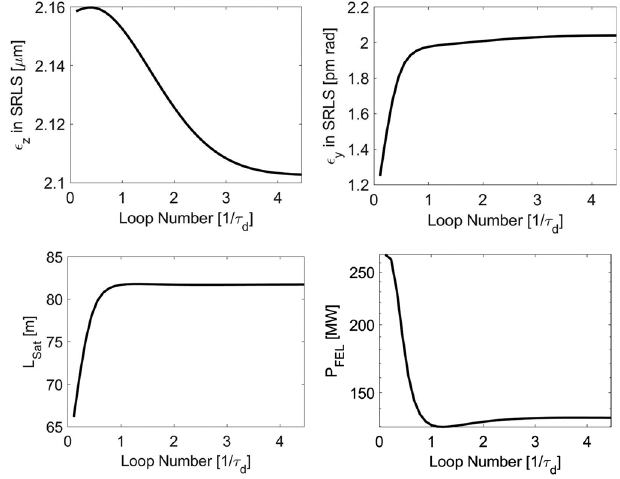
FIG. 8. Same quantities as in Fig. 7, but now the same bunch is lasing every 570 turns in the SRLS (1 kHz).